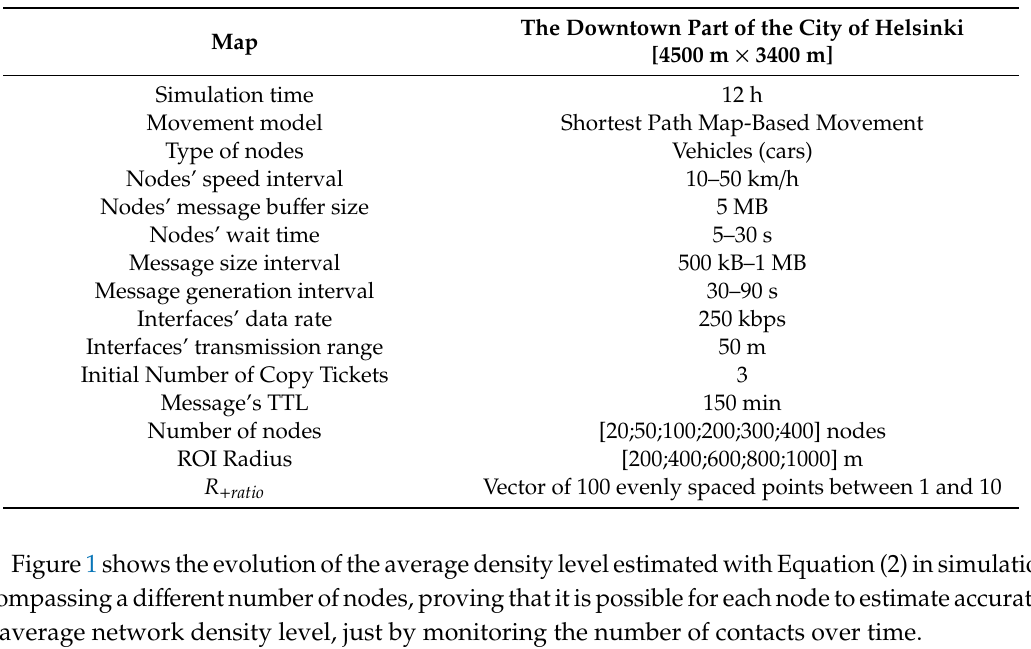
Table 1. Assigned parameters during the simulation procedure.